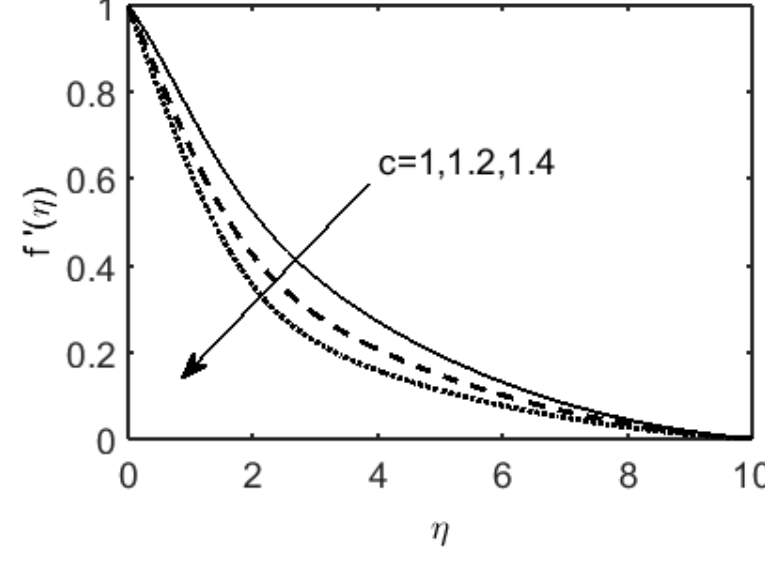
Figure 2. Impact of c on speed.